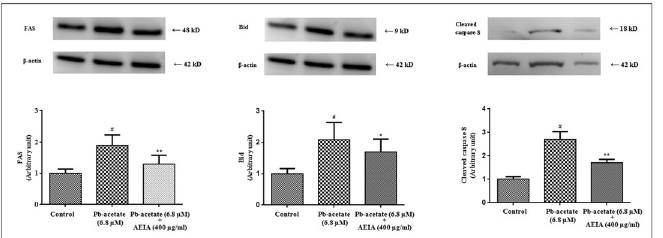
Fig 4. Respective western blot analysis of Fas, Bid and caspase 8 in the absence (Pb-acetate) and existence of AEIA (Pb-acetate + AEIA) in murine hepatocytes. The relative band intensities were measured and the normal control band was given an arbitrary value of 1. β -actin was used as a loading protein. Values are expressed as mean ± SE (n = 3). # Values differed (p < 0.01) significantly from normal control. * Values differed (p < 0.05) significantly from Pb-acetate control. ** Values differed (p < 0.05) significantly from Pb-acetate